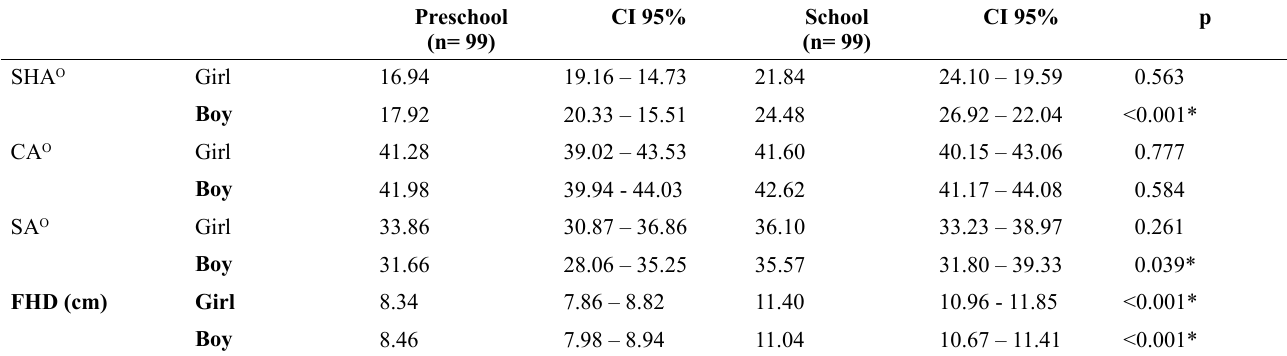
Table 3. Results of postural variables analyzed in both moments – assessment and reassessment for girl and